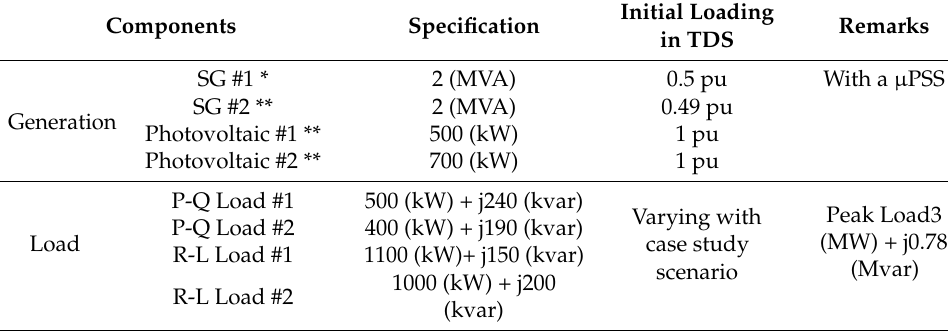
Table A5. Specification of a simulation